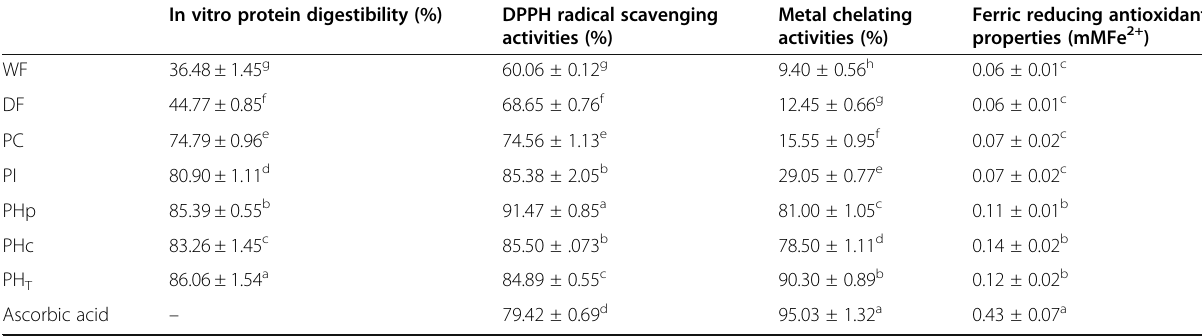
Table 3 In vitro protein digestibility and antioxidant properties of okra seed flours, protein isolate and hydrolysates In vitro protein digestibility